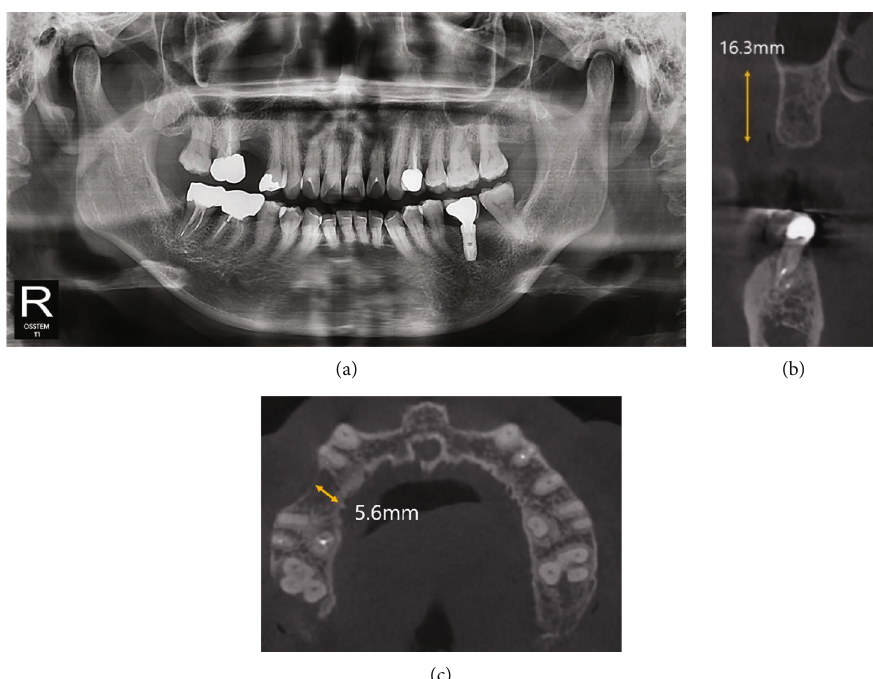
Figure 1: Pre-operative radiographic views (Case 1). (a) Panoramic view. (b) and (c) CBCT view. The height of alveolar bone was su ffi cient, but it can be seen that the width was somewhat